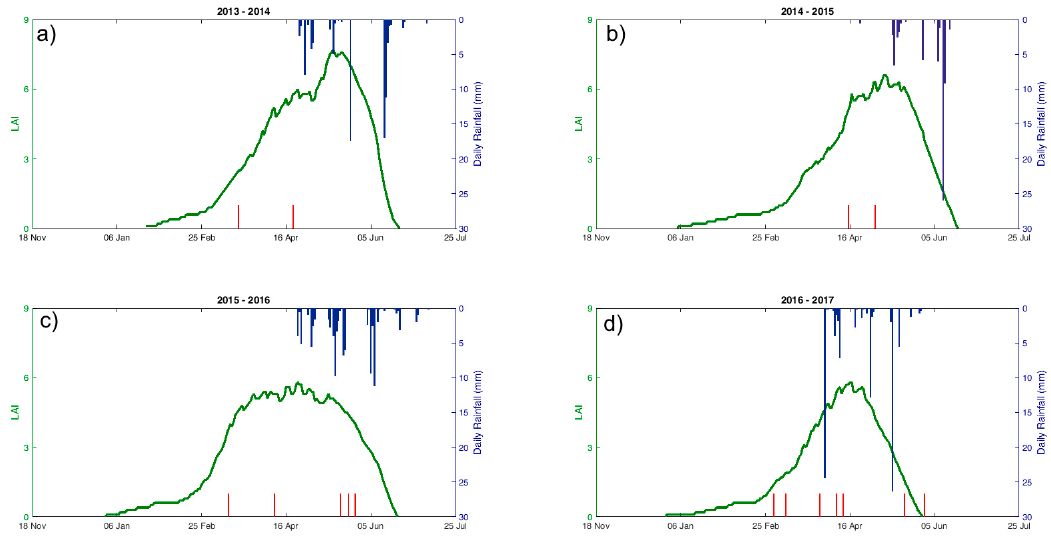
Figure 8. Modelled LAI (green), observed rainfall after heading (blue) and satellite observation (red) for ( a ) 2013–2014, ( b ) 2014–2015, ( c ) 2015–2016 and ( d ) 2016–2017 seasons.